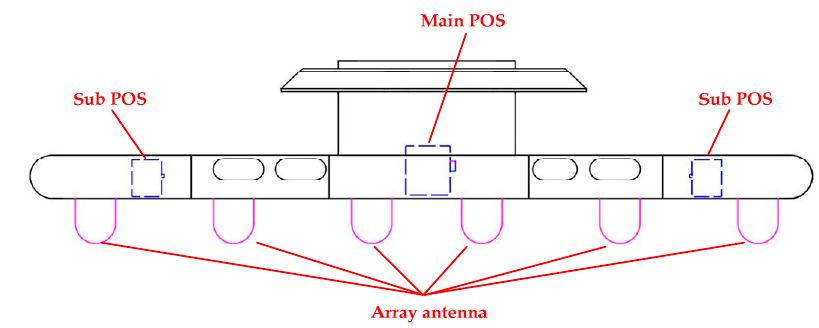
Figure 7. Distributed layout of measurement scheme.